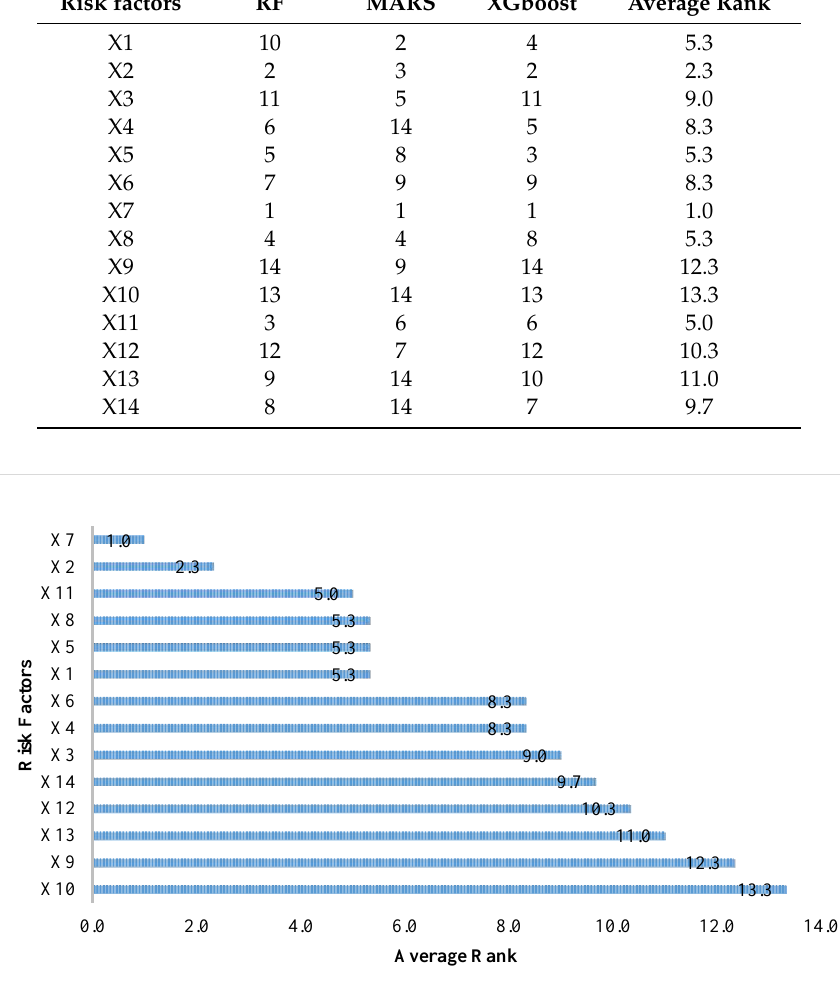
Figure 2. The ranking of all risk factors.